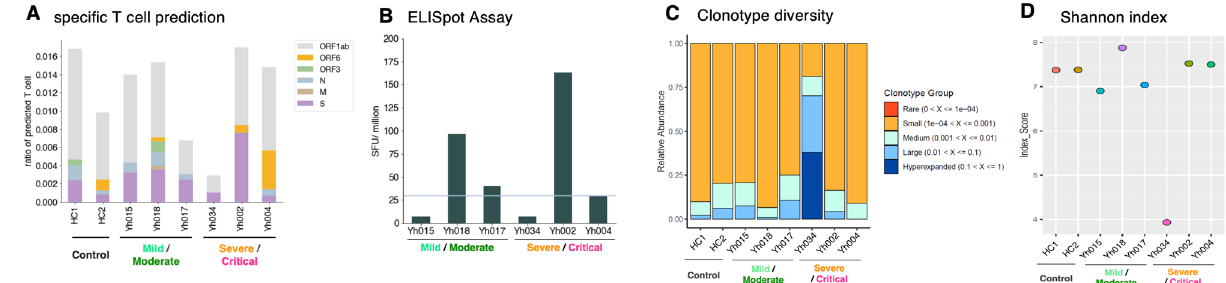
Figure 3. TCR diversity and SARS-CoV-2 specific T cell responses in COVID-19 patients. (A) Ratio of T cells predicted to be specific to SARS-CoV-2 in two healthy controls and six COVID-19 patients. HC1(healthy), HC2 (healthy), Yh015 (mild), Yh018 (mild), Yh017 (moderate), Yh034 (severe), Yh002 (severe), and Yh004 (critical) colored by recognized antigens. The y-axis shows the frequency of T cells predicted to SARS-CoV-2 specific by TCRex. Color key is shown in the margin. (B) SARS-CoV-2 specific T cell population analyzed ex vivo. For ELISpot assay, peptides corresponding to the whole SARS-CoV-2 antigen are used, excluding ORF1ab. Red